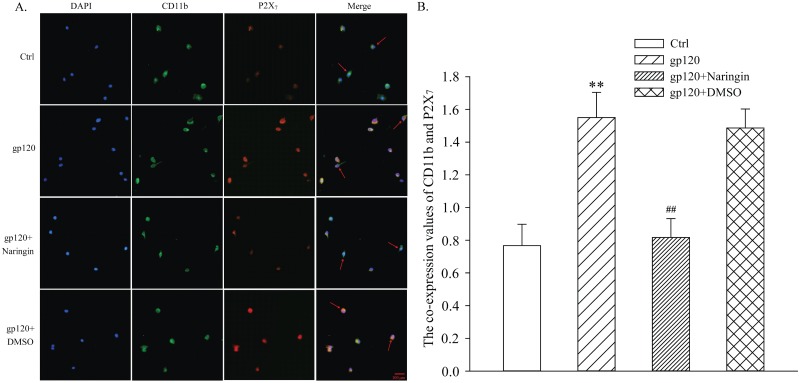
Co-expression of CD11b and P2X7 receptor in primary cultured microglia detected by immunofluorescence double labeling.A, Typical fluorescence image of primary cultured microglia; green signal represents CD11b staining with FITC; red signal indicates P2X7 staining with TRITC; Merge represents the P2X7 and CD11b double staining image; arrows represent microglia with co-expression of P2X7 receptor and CD11b. B, Co-expression values of CD11b and P2X7 receptor in each group; **P < 0.01, versus Ctrl group; ##P < 0.01, versus gp120 group; n = 3.